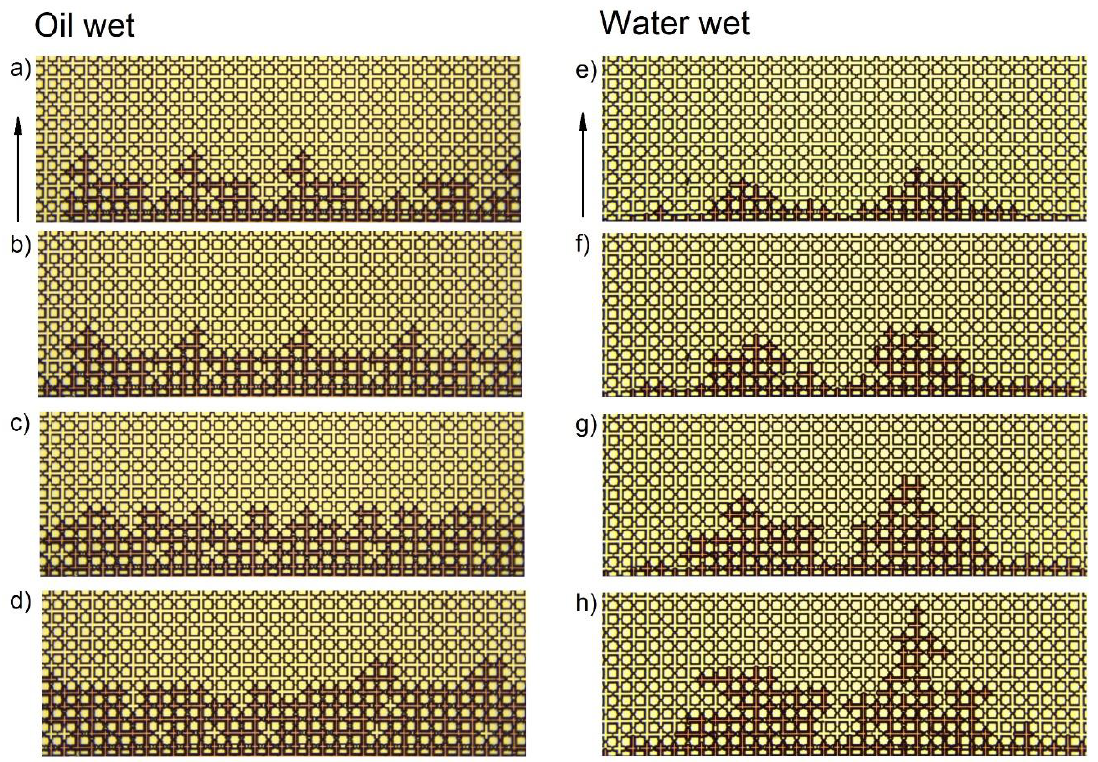
Figure 9. Sequence of images in the early stages of water invasion: ( a – d ) oil-wet media; ( b – h ) water-wet network.